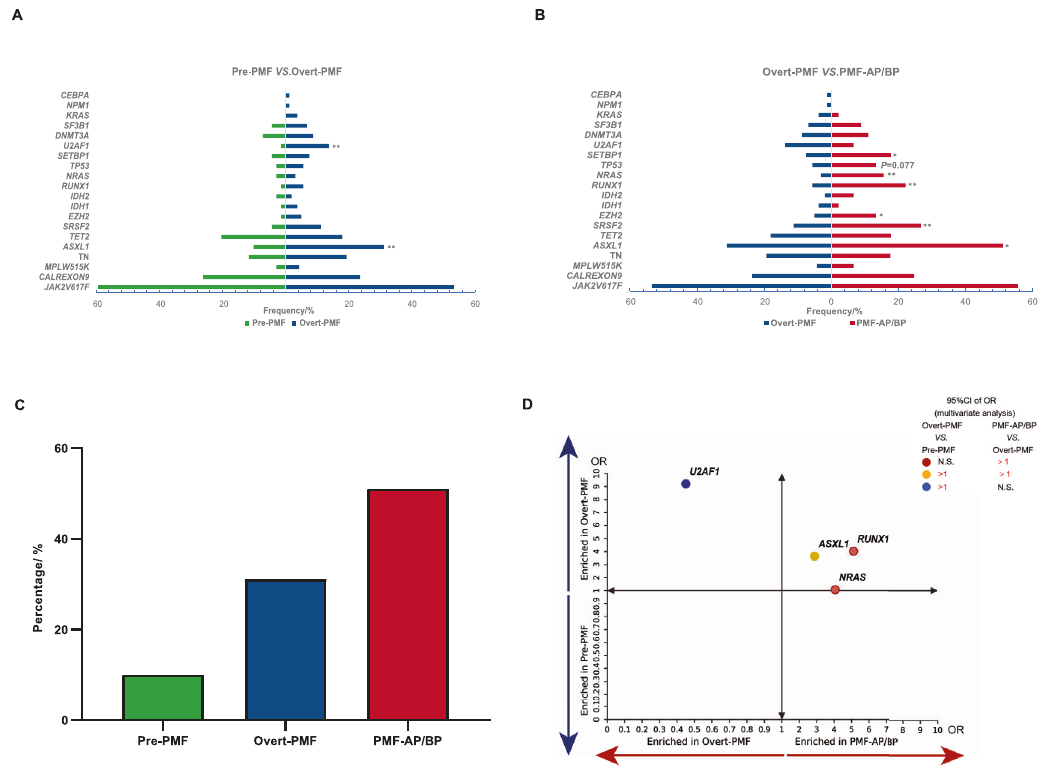
Fig. 1 The association between non-driver mutation and different stages of PMF. Comparison of mutation frequency in Pre-PMF vs. Overt- PMF ( A ) and Overt-PMF vs. PMF-AP/BP patients ( B ). C The frequency of ASXL1 mutations in different stages of PMF. D Enrichment of non-driver mutations in PMF-AP/BP and Overt-PMF relative to Overt-PMF and Pre-PMF, respectively. Enrichment is expressed as an odds ratio (OR) of mutation rates in PMF-AP/BP vs. Overt-PMF on the x-axis and Overt-PMF vs. Pre-PMF on the y-axis. Mutations showing signi fi cant enrichment in either comparison are indicated by colors according to OR 95% CI limits being above (if OR > 1) or below (if OR < 1). * P < 0 .05; ** P < 0.01; *** P <